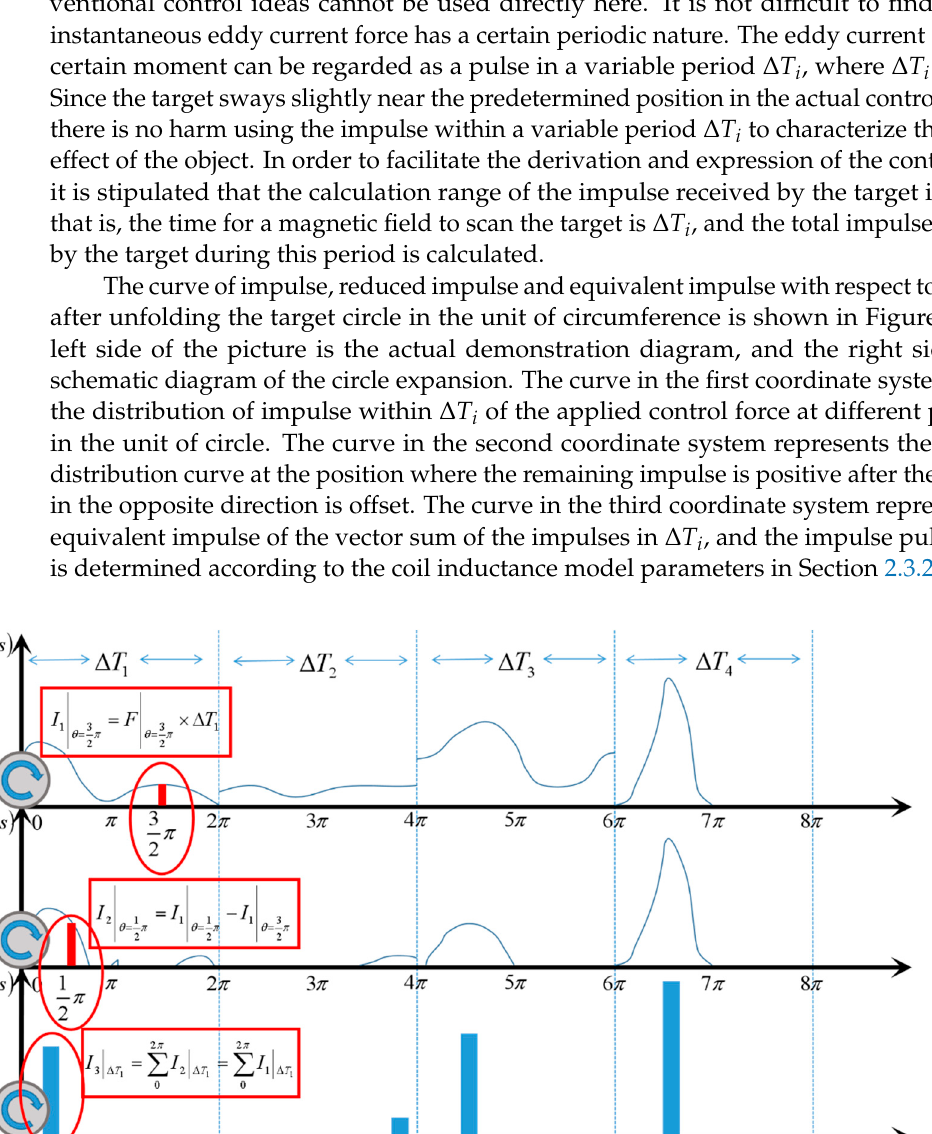
Figure 11. Diagram of inverse solution result. In the two-dimensional plane model, the magnetic angular velocity required in Re- sult 1 is much smaller than that in Result 2. A larger magnetic angular velocity may in- crease the difficulty of controlling the magnetic field generator. In addition, the eddy cur- rent torque in result 1 is opposite to the target speed, which plays a role of braking. The eddy current torque in result 2 is in the same direction as the target speed, which acceler- ates the target’s rotation speed. Therefore, when solving Equation (3), it is necessary to make the applied magnetic field speed as small as possible and the eddy current torque